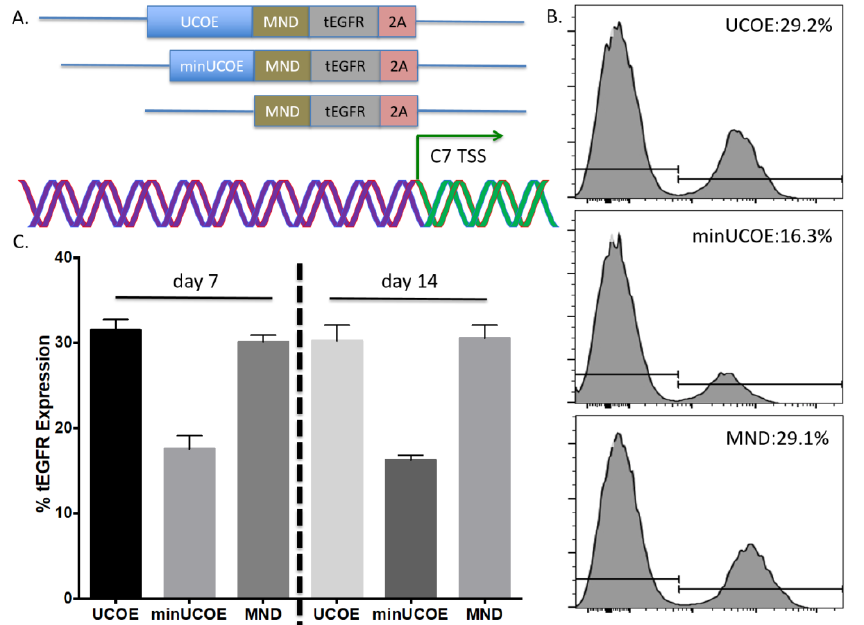
Figure 4. COL7A1 promoter targeting with transcriptional promoting elements for T-cell